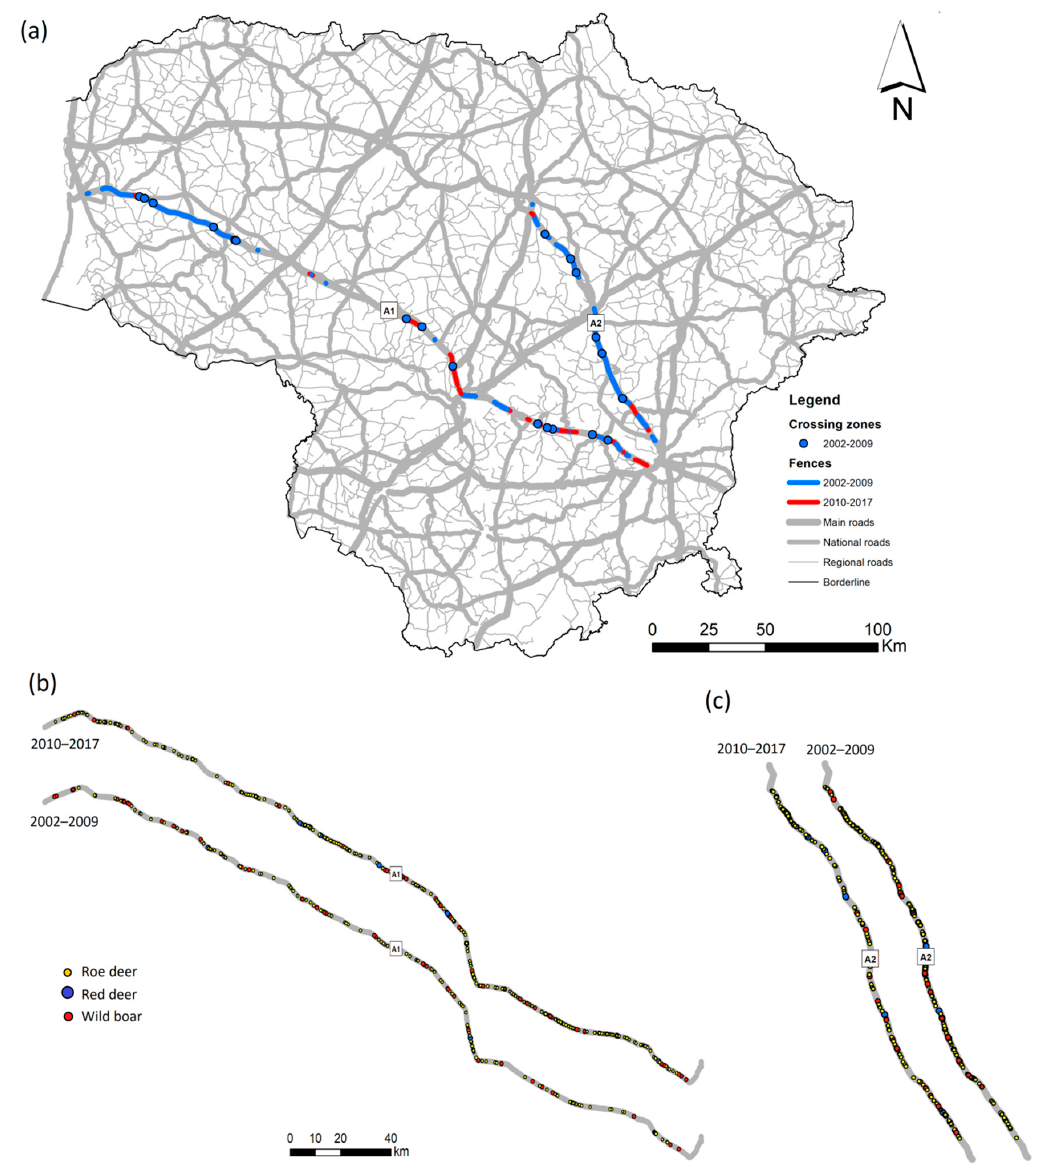
Figure 6. Location of multi-species crossing zones in 2002–2009 ( a ), ungulate-vehicle collision sites of highways A1 ( b ) and A2 ( c ) in 2002–2009 and 2010–2017.